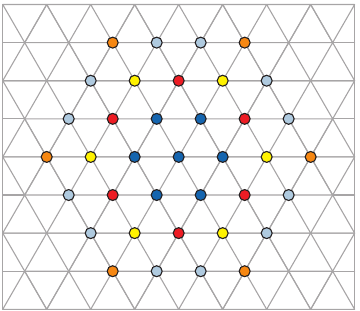
Figure A1. Triangle Wigner 2D lattice of electrons with indicated nearest neighbors and next-nearest ones up to a 4th